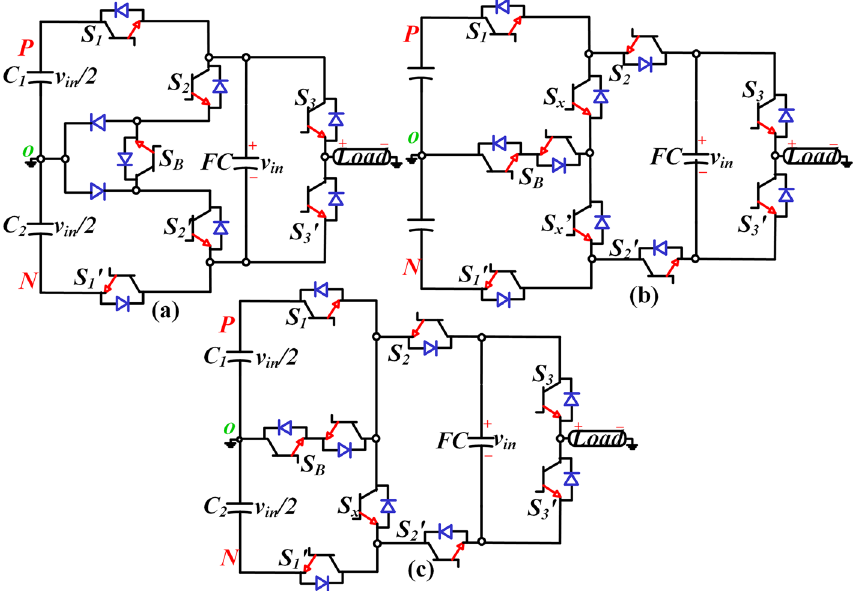
Figure 1. Boost ANPC type inverter topologies ( a ) 5L-ANPC topology presented in Ref. 7 , 7L-ANPC topology presented in ( b ) 9 , and ( c ) 13,14